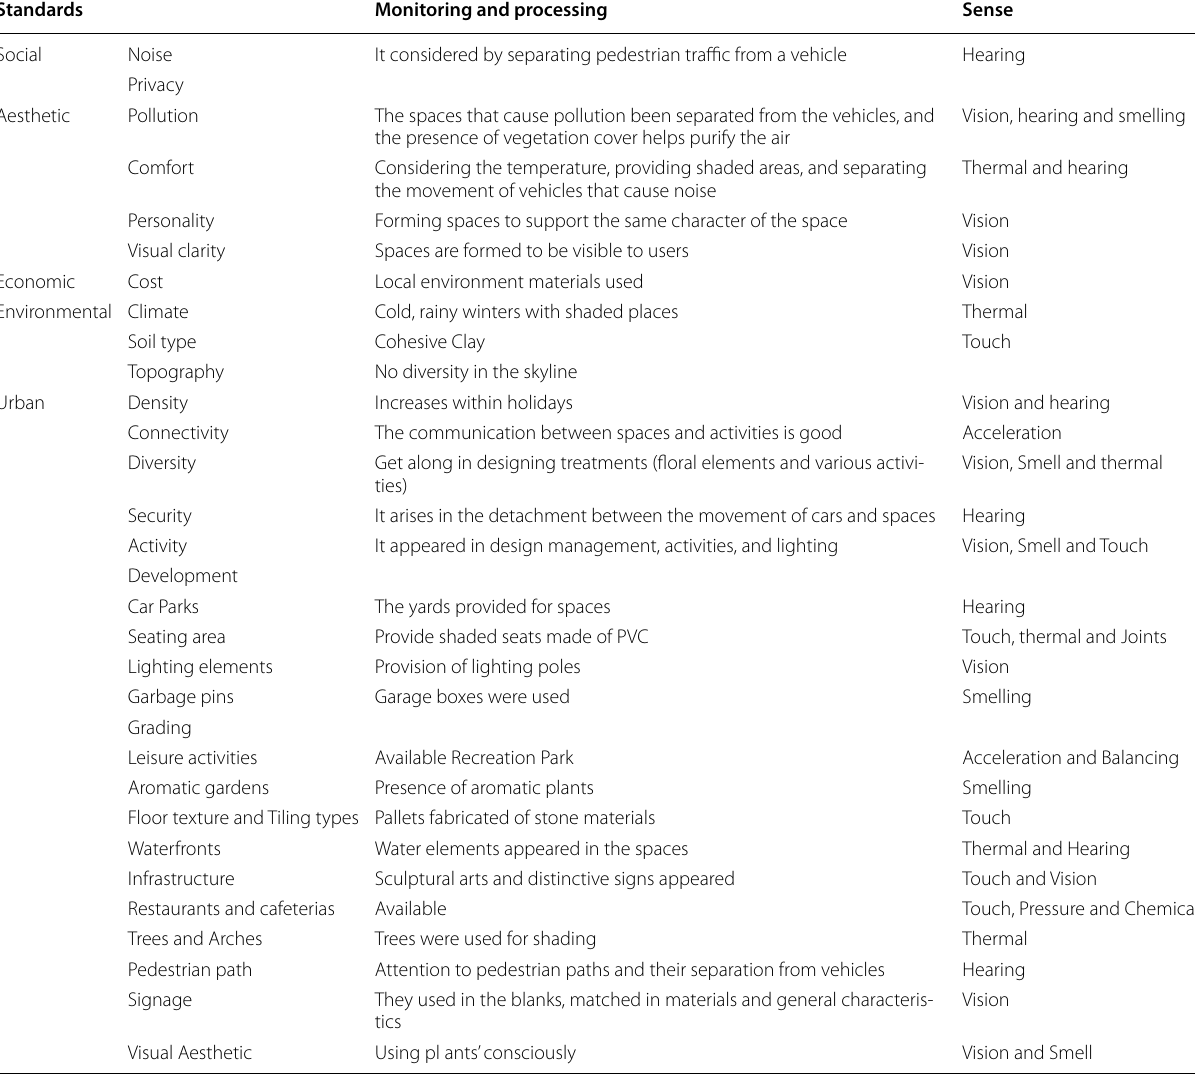
Table 3 Design criteria considered when analyzing spaces in